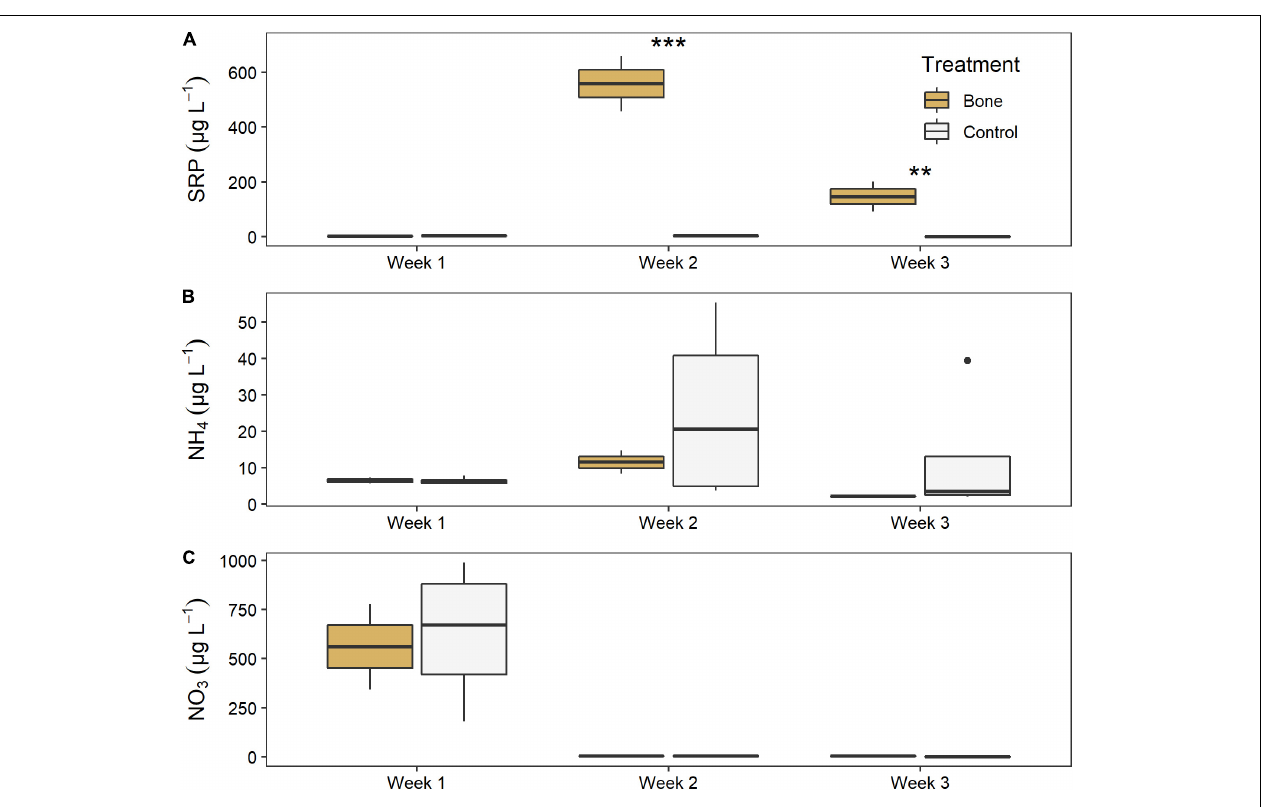
F 1 , 11 = 9.13, p = 0.017) than biofilms on rocks ( Figure 8 ). Chl